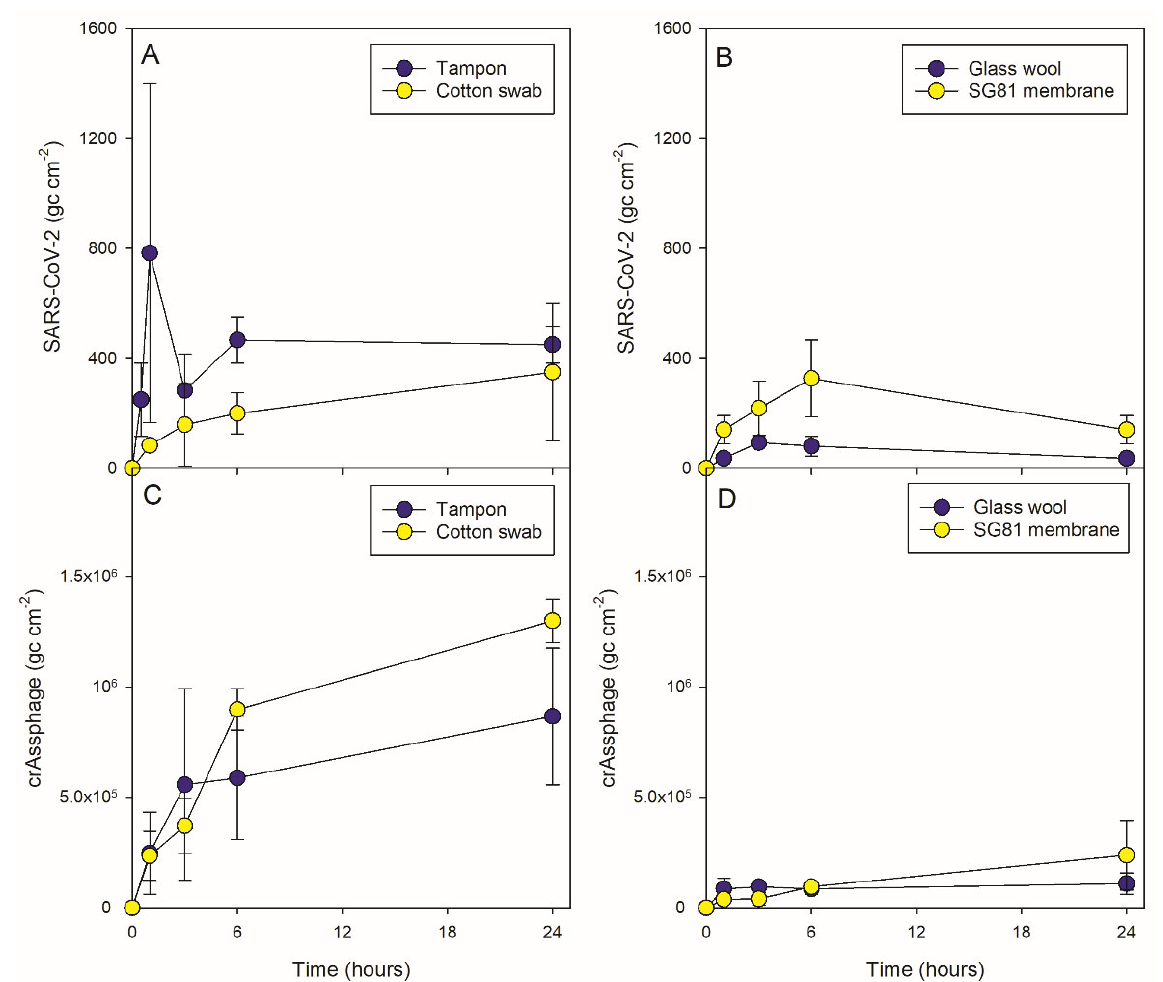
Figure 4. Assessment of exposure time (0–24 h) on the accumulation of ( A , B ) SARS-CoV-2 (upper panels) and ( C , D ) the human faecal marker virus crAssphage from four different passive samplers after deployment at a centralized wastewater treatment plant. Values represent means ± SEM ( n = 3). The two sets of graph panels represent different experimental days and therefore cannot be directly compared.